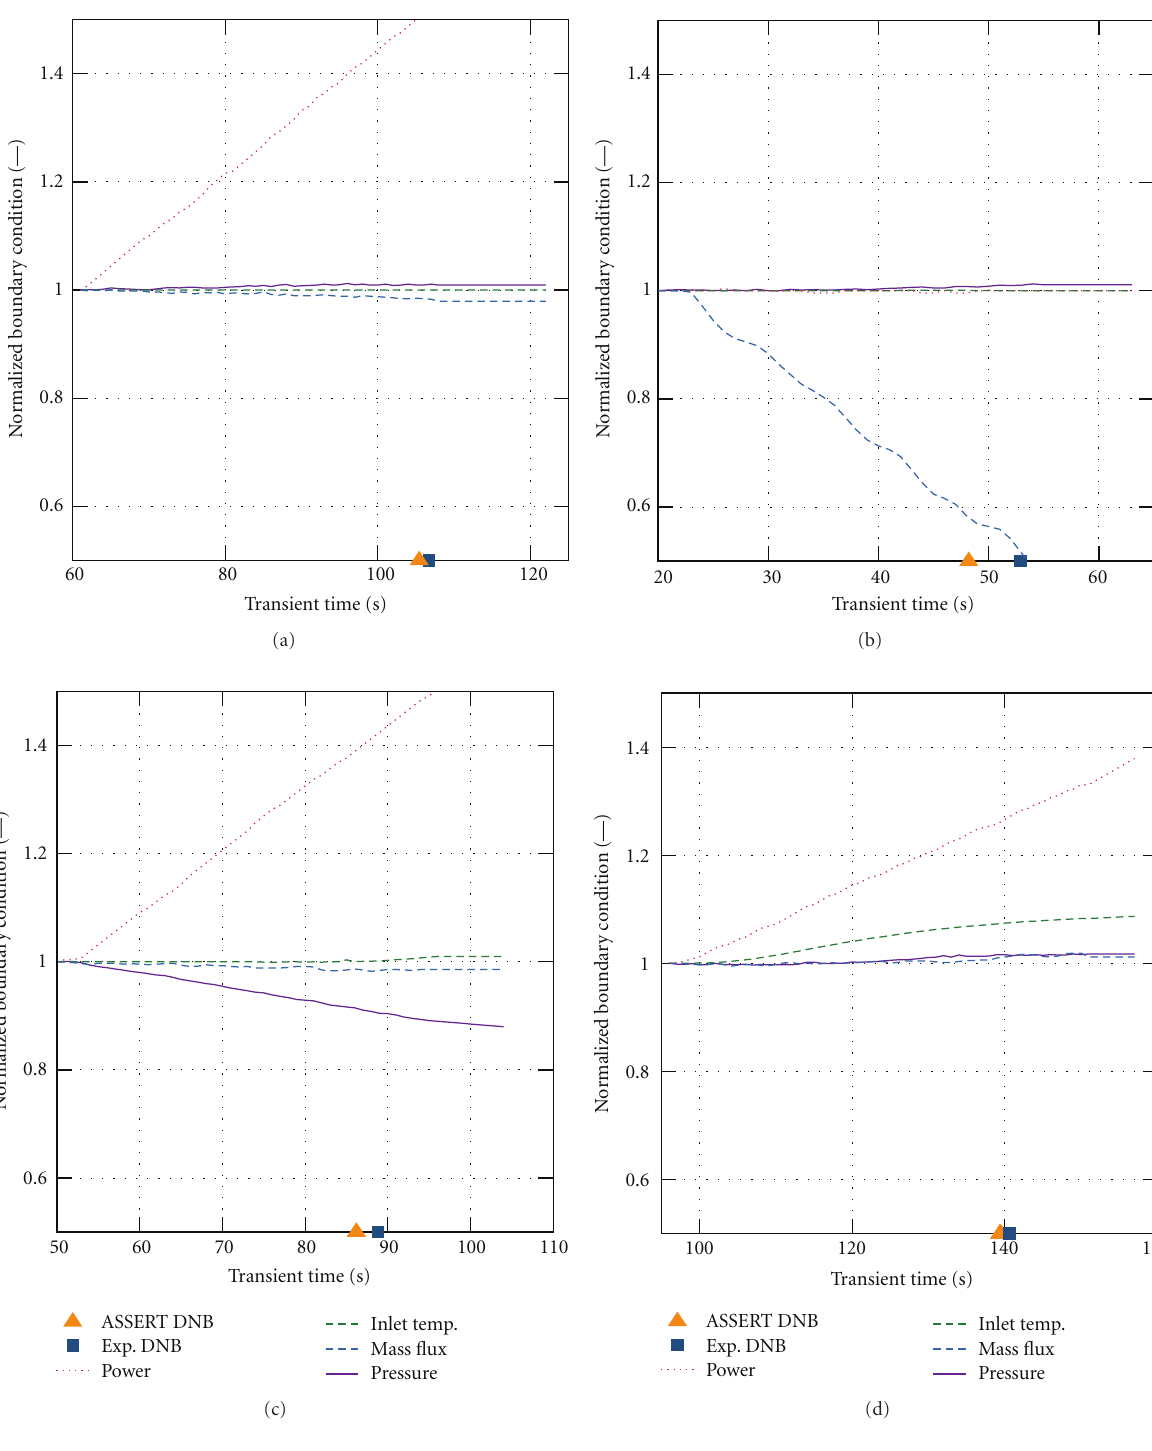
Figure 19: Transient departure from nucleate boiling results for test series A11. Power increase (a), flow reduction (b), depressurization (c), and inlet temperature increase (d). Estimated uncertainty on the power measurements is 2 σ exp =